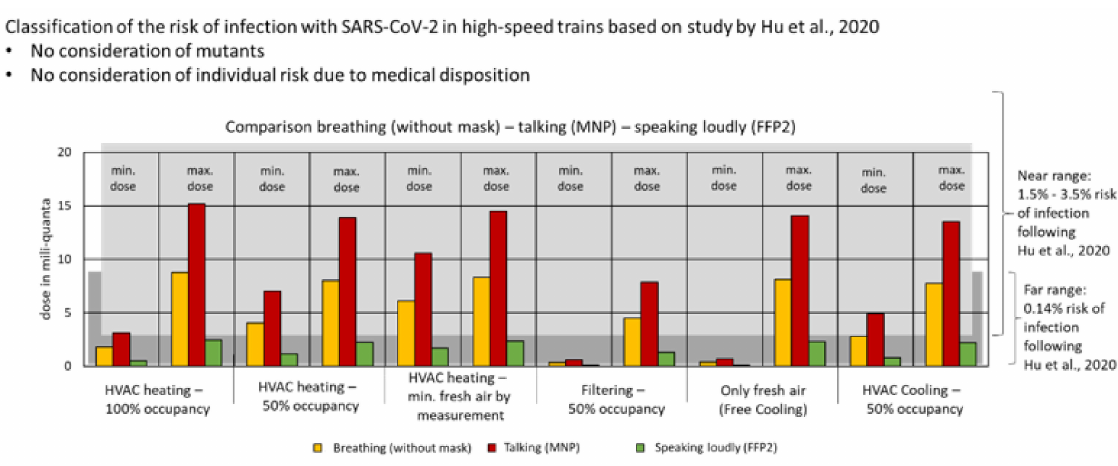
Figure 14. Comparison of the dose in mili-quanta determined in the simulation in the area farther away from the infected person compared to the determined probability of infection according to Hu et al.